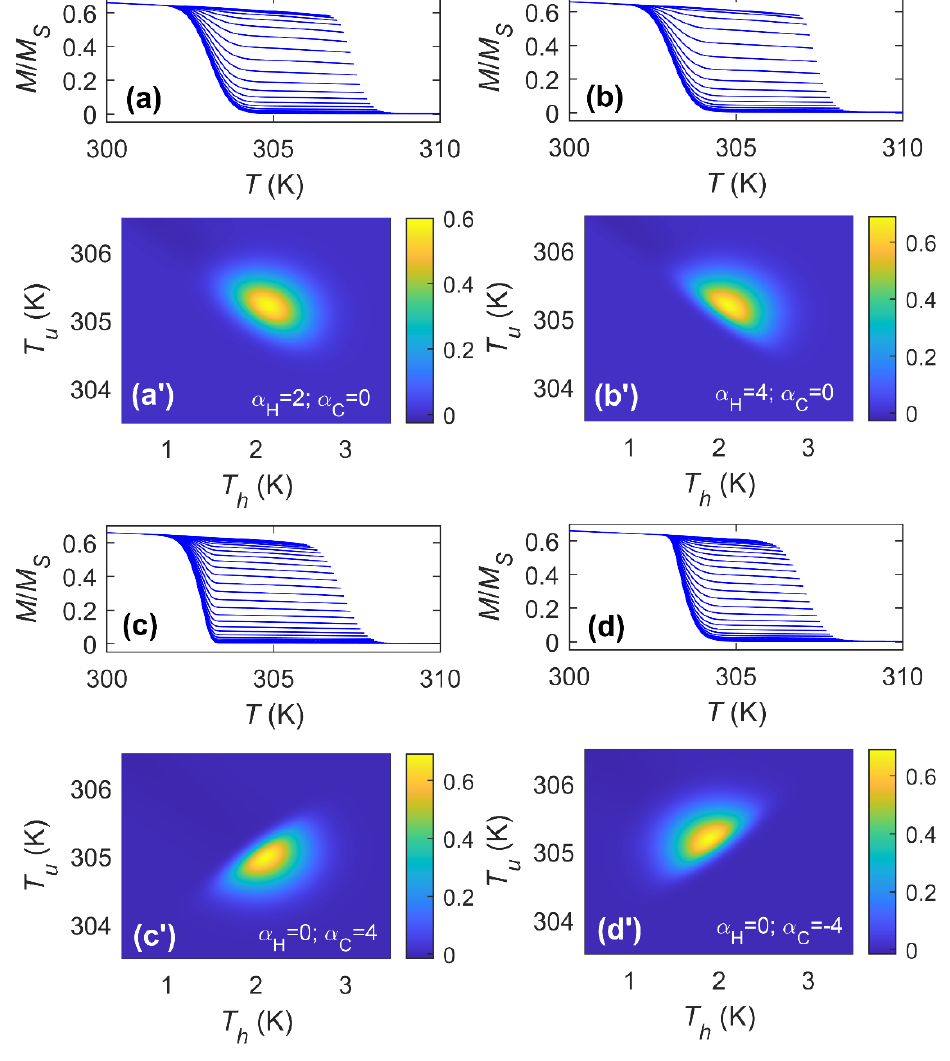
Figure 7. Cooling first order reversal magnetization curves and associated TFORC distributions with (cid:2022) (cid:3009) = (cid:1846) (cid:3047),(cid:3020)(cid:3021) + 2 K , (cid:2022) (cid:3004) = (cid:1846) (cid:3047),(cid:3020)(cid:3021) − 2 K , (cid:2026) (cid:3009) = (cid:2026) (cid:3004) = 0.5 K and different skewness factor combinations: ( a ) – ( a’ ) (cid:2009) (cid:3009) = 2 , (cid:2009) (cid:3004) = 0 , ( b )–( b’ ) (cid:2009) (cid:3009) = 4 , (cid:2009) (cid:3004) = 0 , ( c )–( c’ ) (cid:2009) (cid:3009) = 0 , (cid:2009) (cid:3004) = 4 and ( d )–( d’ ) (cid:2009) (cid:3009) = 0 , (cid:2009) (cid:3004) =